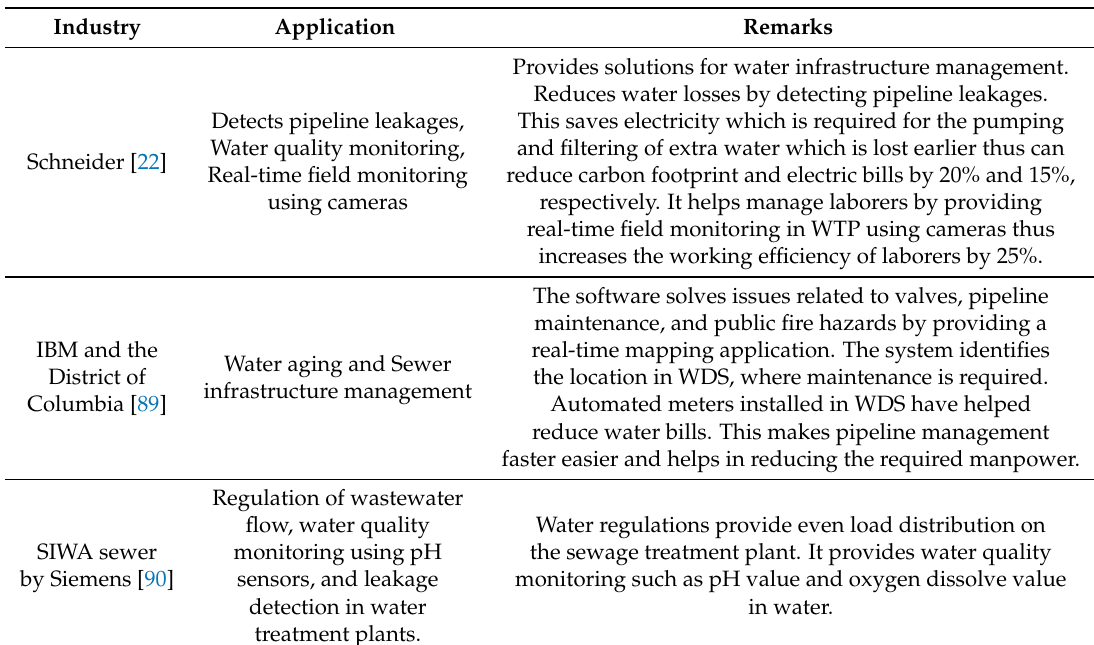
Table 5. Smart technologies for water treatment plants by industry